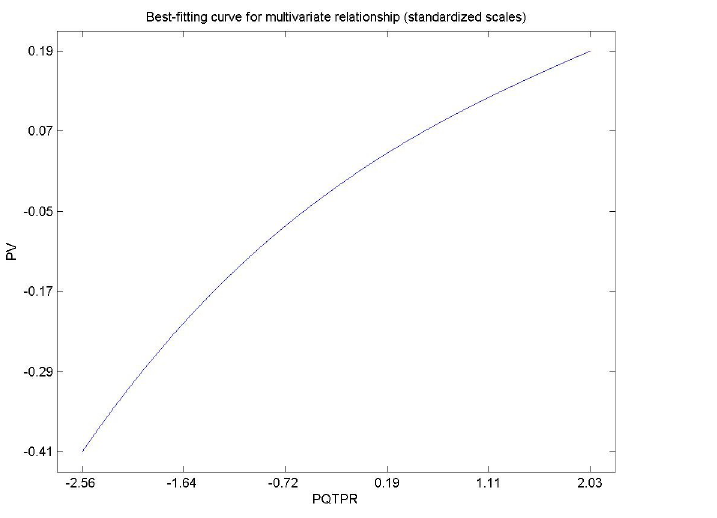
Fig 6. Hypothesis 4, PQTRP-PV.